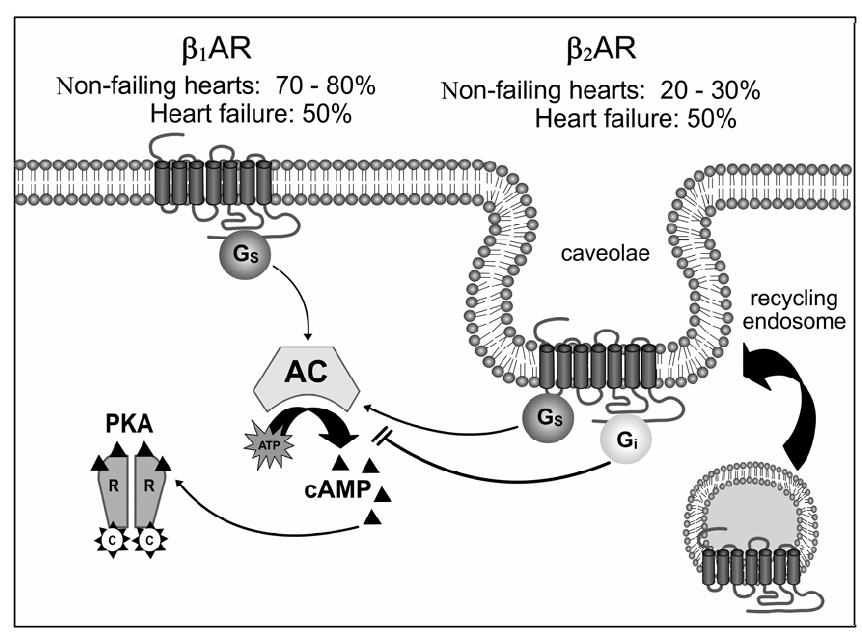
Fig. 2 – Distinct intracellular signaling pathways and subcellular localization of β 1 and β 2 adrenergic receptors ( β 1 AR and β 2 AR) in cardiomyocytes. β 1 ARs mediate chronotropic and inotropic effects of catecholamines via the stimulatory G protein (G s ). β 2 ARs are normally confined to caveola in cardiomyocyte membranes and this localization is essential for its physiological signaling. β 2 ARs mediate transient increase in contraction rate of cardiomyocytes via G s . However, β 2 ARs also couple to inhibitory G protein (G i ), which results in antiapoptotic effects on cardiomyocytes. AC, adenylyl cyclase; cAMP, cyclic AMP; PKA, cAMP-dependent protein kinase